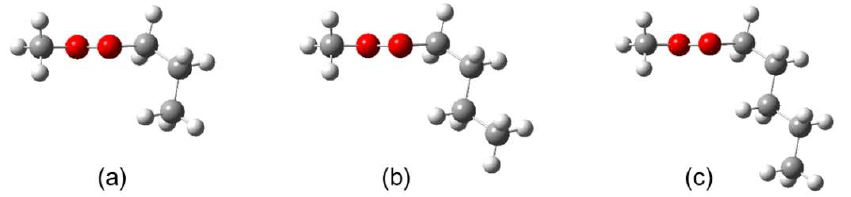
Figure 4. The most stable conformer I of ( a ) methyl butyrate, ( b ) methyl valerate, and ( c ) methyl hexanoate optimized at the MP2/6-311++G(d,p) level of theory. For atom colors, see Figure 1.